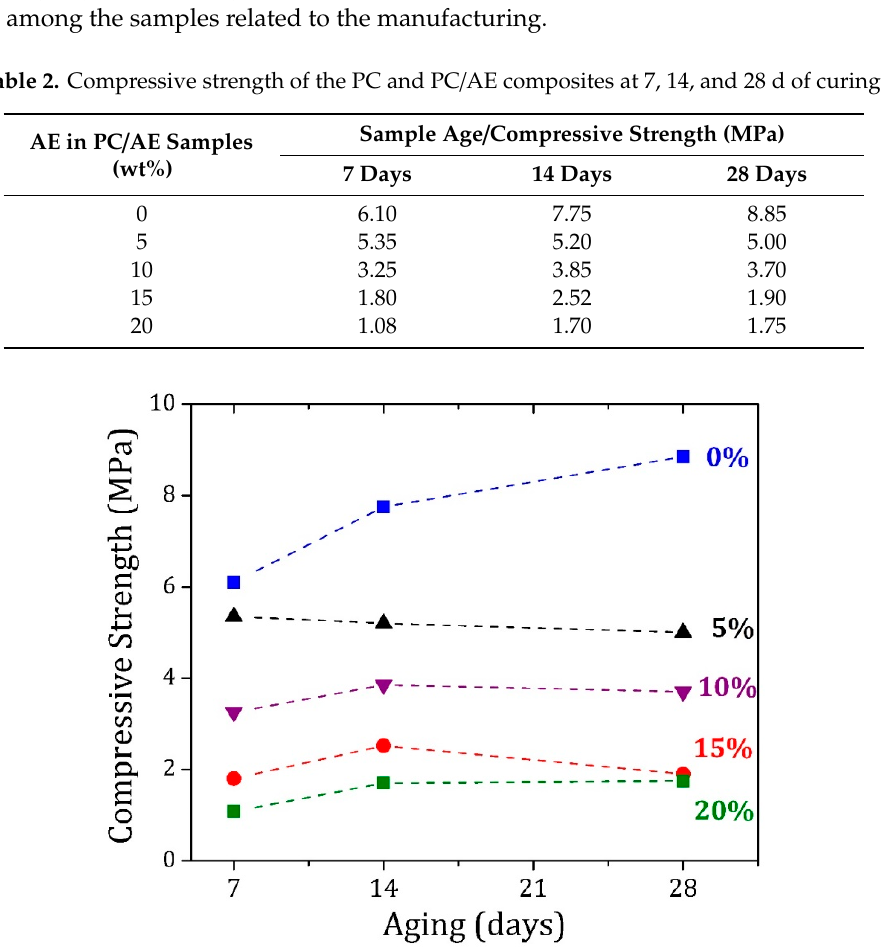
Figure 7. Compressive strength of the PC and PC/AE bricks for different ages.